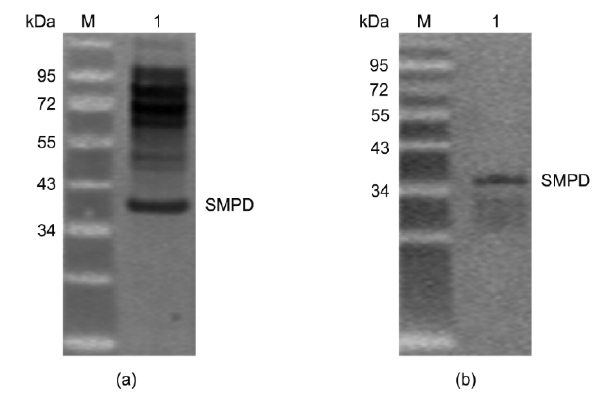
Fig 5 . SMPD polyclonalantibody (a) and His-tag monoclonal antibody (b) against the expressed His-SMPD fusion protein.